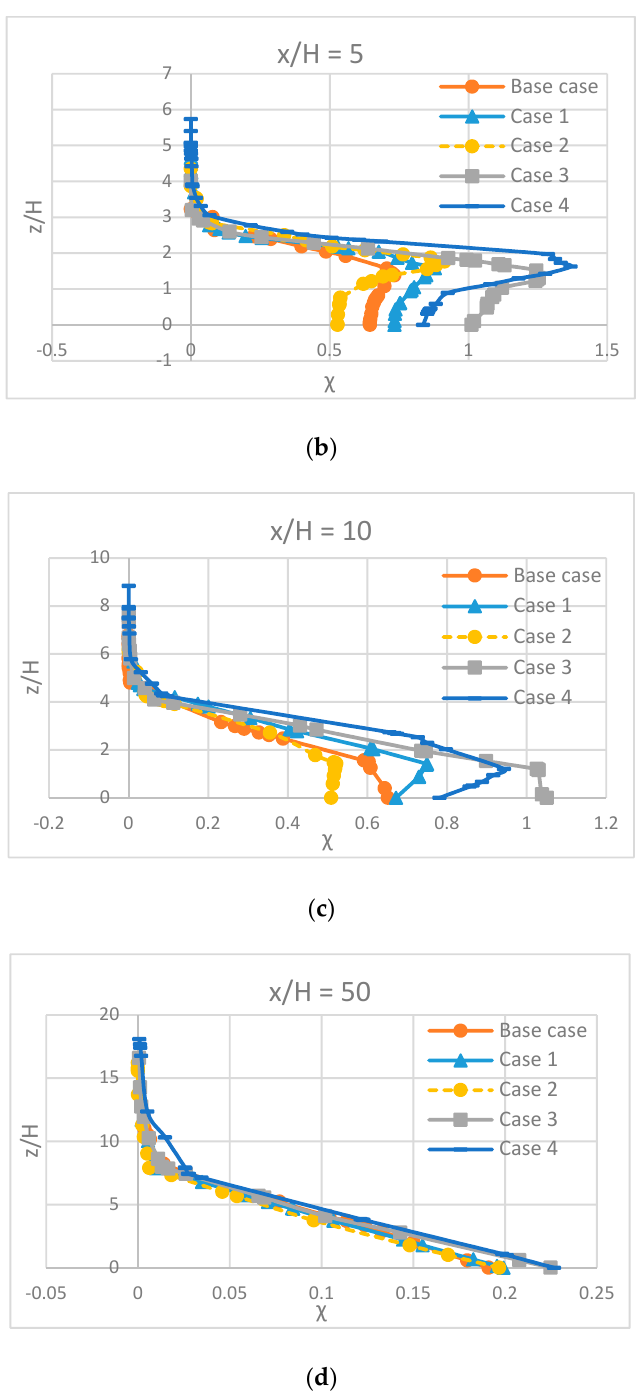
Figure 20. Vertical distribution of CO normalized concentration at different locations (H = 6 m). ( a ) x/H = 0: on the highway; ( b )( c ) x/H = 5, 10: near the highway; ( d ) x/H = 50: far downstream.